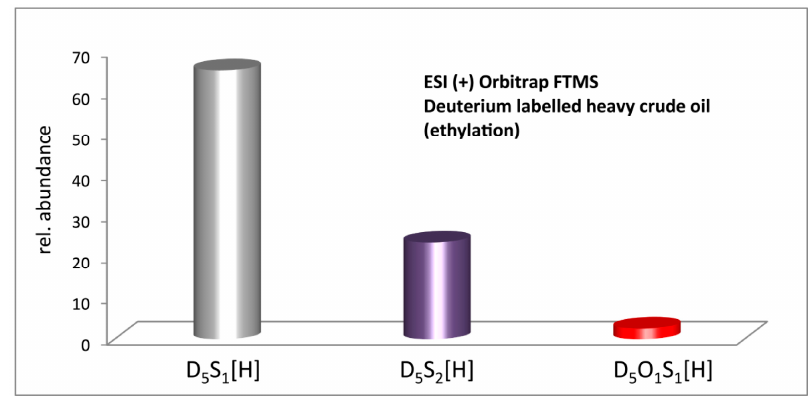
Figure 6. Heteroatom class distribution of heavy crude oil after deuterium labelled ethylation.